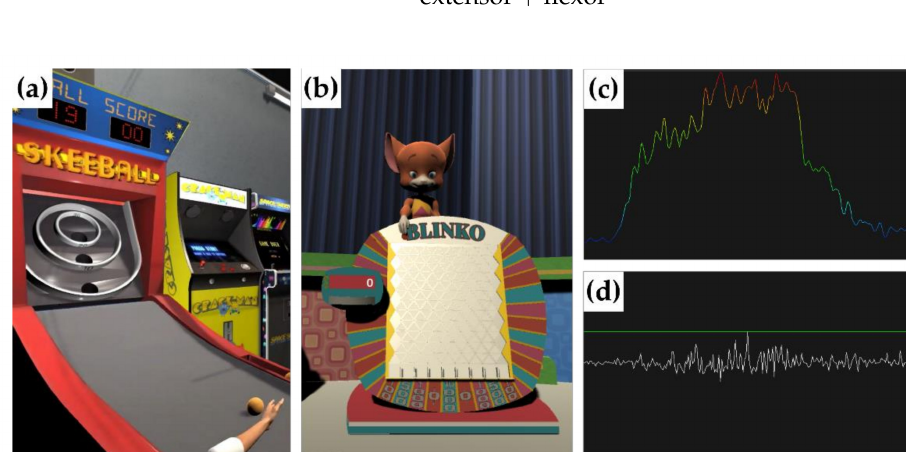
Figure 2. Examples of EMG biofeedback games. ( a ) SkeeBall : adequate extensor ratio muscle activity translates as movement of the arm shooting the ball to different targets. ( b ) Blinko : adequate extensor ratio muscle activity translates as movement of the character left and right, who then drops a chip to win points. ( c ) SeeEMG : smooth EMG is mapped to show high amplitudes in red and low amplitudes in blue. A dynamic range to scale amplitudes can be modified by the clinician. ( d ) SeeEMG : down- sampled rectified EMG. The green horizontal line represents the maximum value reached in that